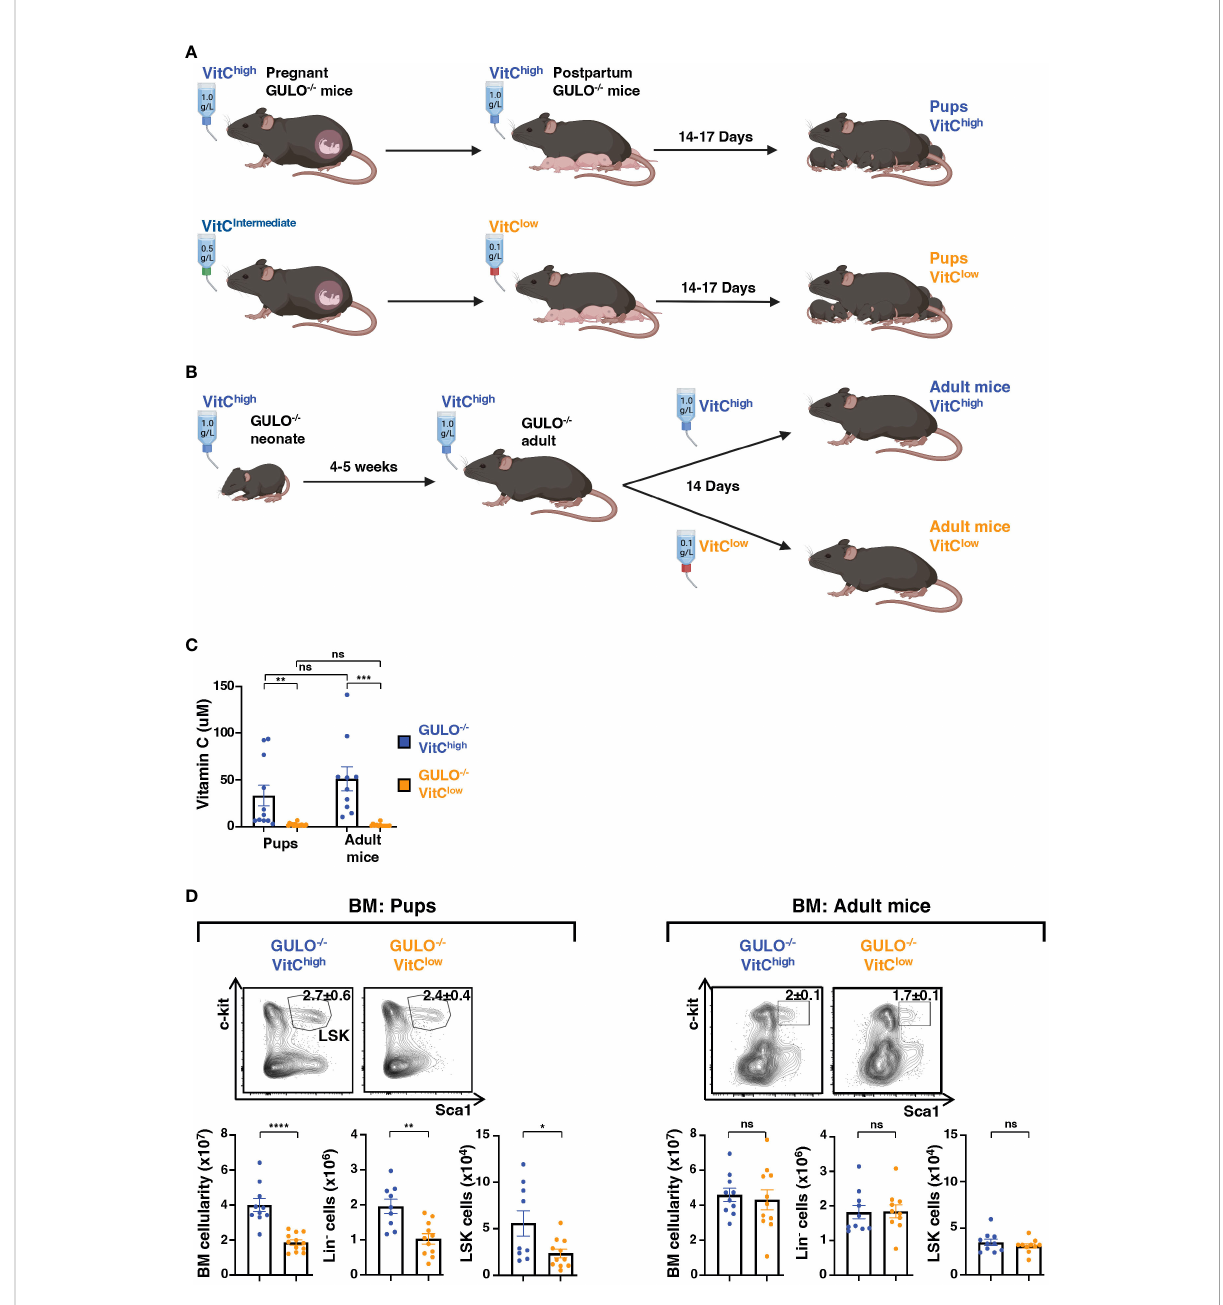
FIGURE 1 Ascorbate de fi ciency in neonatal GULO -/- mice results in a signi fi cant reduction in bone marrow hematopoietic progenitors. (A) Schema illustrating the protocol used to generate ascorbate-de fi cient GULO -/- pups. GULO -/- pregnant dams were supplemented with vitamin C (VitC) in the drinking water, either at 1g/L for the high dose group (upper panel) and 0.5g/L for the intermediate dose group (lower panel). Following the birth of pups, dams were either maintained at the high dose of vitamin C (1g/L) or the dose was decreased to 0.1g/L in the low dose group. (B) Schema illustrating the protocol used to generate adult GULO -/- mice (6-7 weeks) with ascorbate de fi ciency, by decreasing vitamin C in the drinking water of adult mice (4-5 weeks of age) from 1.0g/L to 0.1g/L for 14 days. (C) Plasma vitamin C concentrations were measured by HPLC in pups and adult mice maintained on high or low dose vitamin C as detailed in panels (A, B) Means ± SEM are presented (n=10-15 mice per group). (D) Total bone marrow (BM) cells, lineage - hematopoietic progenitors (Lin - ), and Lin - Sca1 + c-kit + (LSK) progenitors were quanti fi ed in pups (left) and adult (right) GULO -/- mice supplemented with 1g/L of vitamin C (GULO -/- VitC high , blue) or 0.1g/L of vitamin C (GULO -/- VitC low , orange). Representative contour plots showing the c-kit/Sca1 pro fi les in Lin - cells are presented and means ± SEM are indicated (n=9-12 mice per group). Statistical differences were evaluated by an unpaired two-tailed t-test. *p<0.05; **p < 0.01; ***p < 0.001; ****p < 0.0001; ns, not signi fi